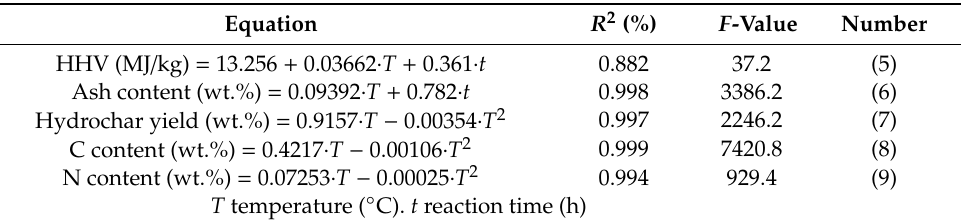
Table 3. Equations derived from the analysis of variance (ANOVA).